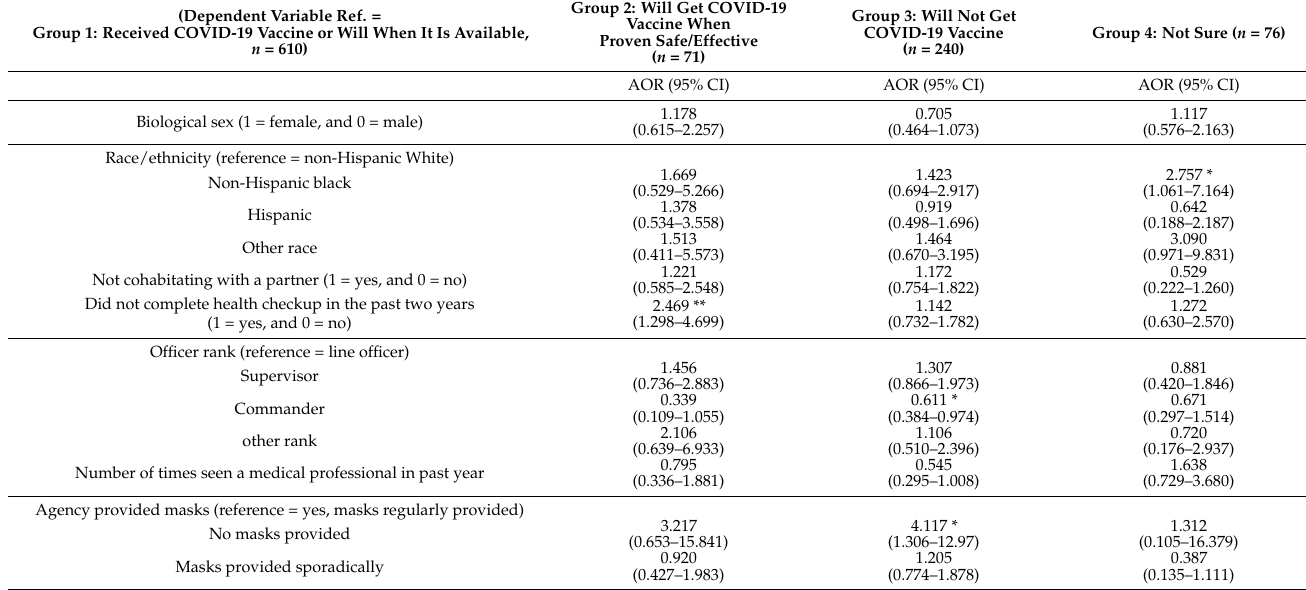
Table 4. Multinomial logistic regression for COVID-19 vaccine hesitancy ( n =